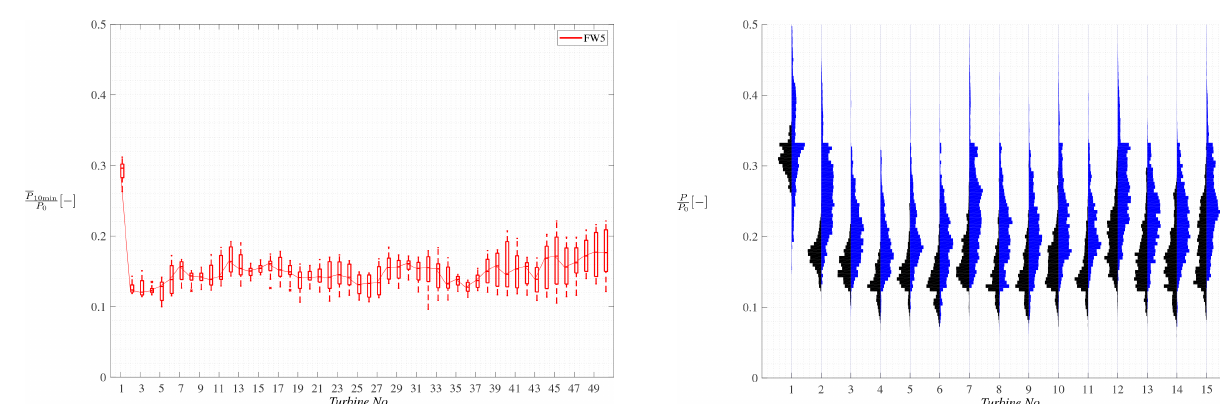
Figure 3. Box plots of all 50 turbines for FW5 with TI = 10% and S X × S Y = 12 R × 20 R . Outliers not shown for clarity.